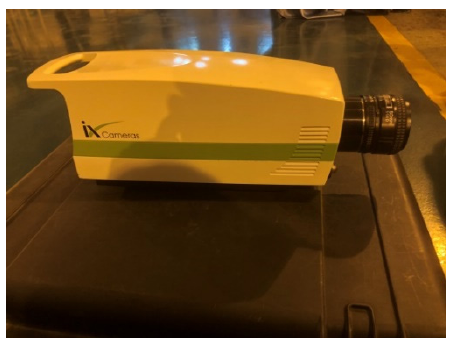
Figure 6. High-speed camera.